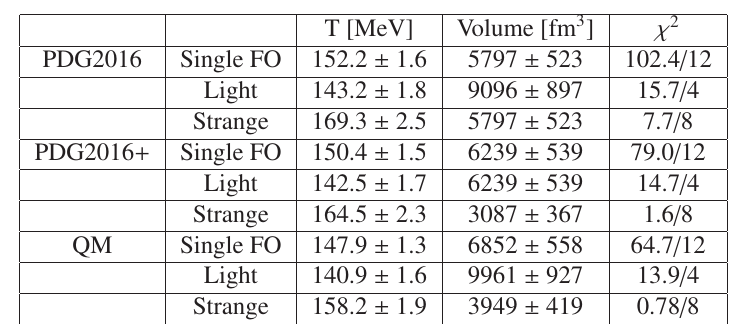
10% collisions, in comparison Figure 1. ALICE PbPb √ s NN = 5 . 02 GeV data for particle yields in 0 − to HRG model calculations with di ff erent resonance lists; deviations in units of experimental errors σ Table 1. Fit parameters for the two chemical freeze-out scenarios obtained from fits to total yields of are shown below each panel. ALICE data [19–22] for 0 10% centrality in PbPb collisions at √ s NN = 5 . 02 TeV, using di ff erent − lists. Here, we fix the baryon chemical potential to a value 1 MeV.